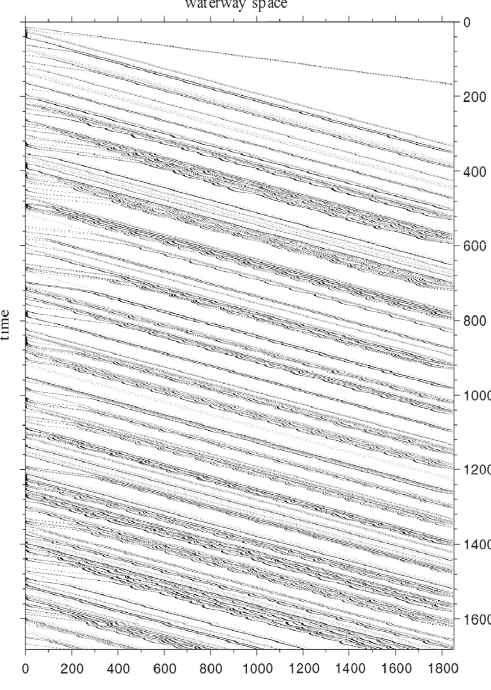
Figure 4. Inbound spatial-temporal spot diagram when allow changing